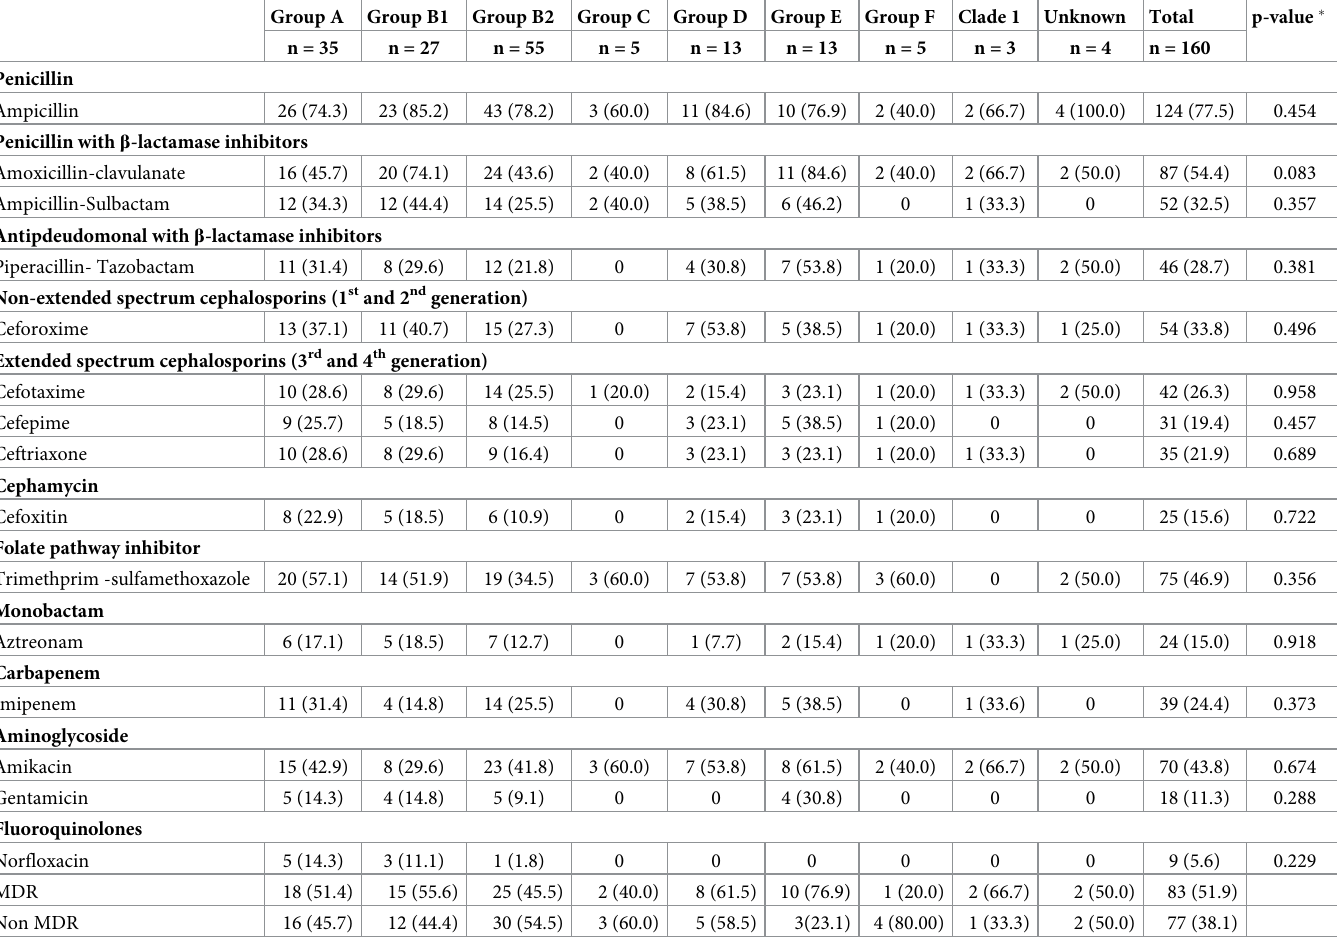
Table 6. Antibiotic resistance profile of E . coli among different phylogroups. Group A Group B1 Group B2 Group C Group D Group E Group F Clade 1 Unknown